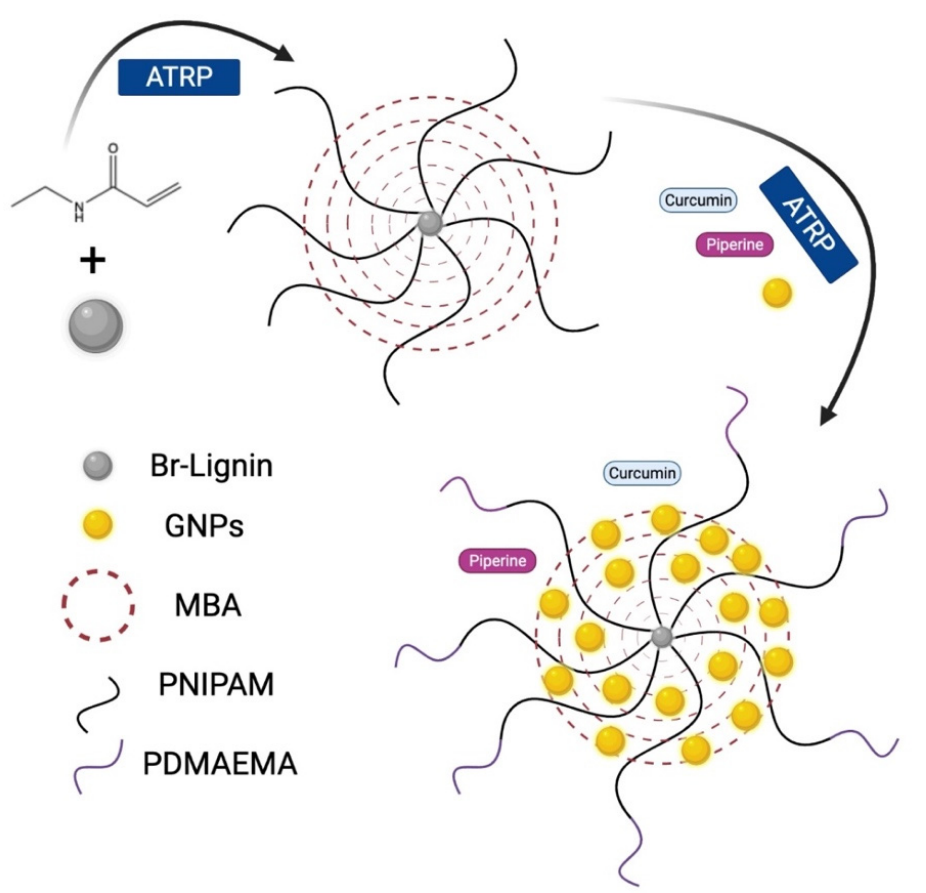
Figure 1. Schematic representation of the synthesis of Lignin-g- p (NIPAM-co-DMAEMA) gold nanogels.